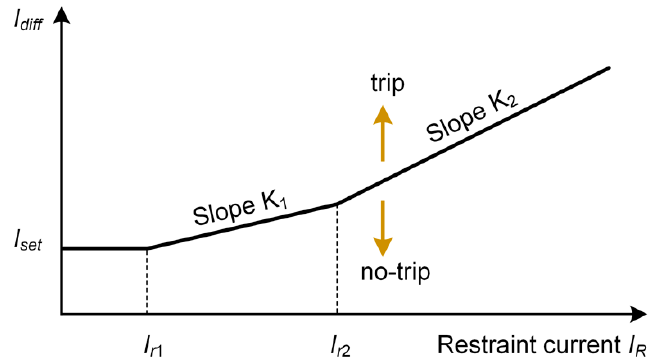
Figure 5. Characteristic curve of directional overcurrent relays (DCR).